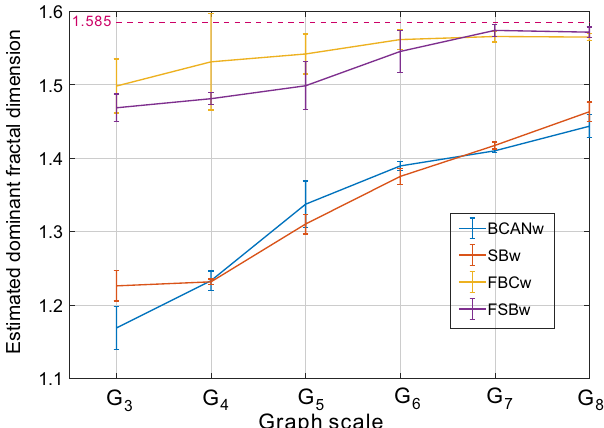
Figure 9. Estimated dominant fractal dimension of Sierpinski fractal network family ( G 3 to G 8 with b = 3 and s = 1/2) using BCANw, SBw, FBCw and FSBw. As predicted by Eqs (13) and (17), the estimation accuracy is improved as the numerical calculation of the limit by the linear regression is performed over a growing set of observations. However, the increased skewness of link weight distribution prevents BCANw and SBw from approaching the theoretical value as quickly as the proposed FBCw and FSBw